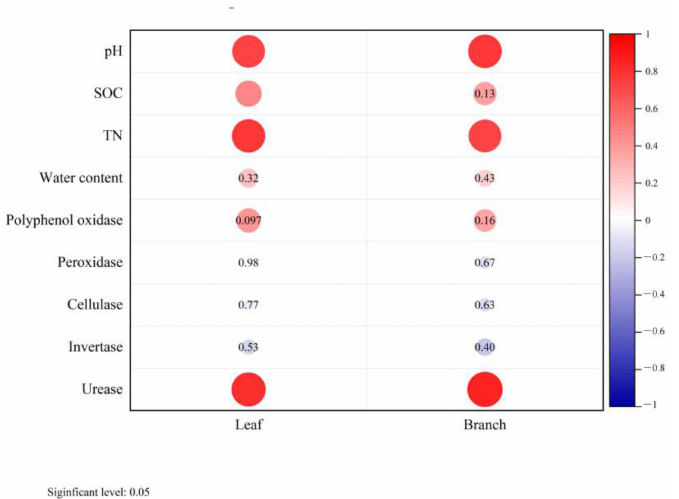
Figure 5. Relationship between soil properties and biomass of moso bamboo leaf and branch. SOC: soil organic carbon, TN: soil total nitrogen. Red color indicates significant difference at p <